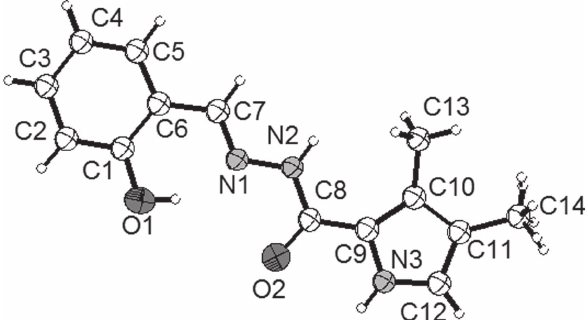
Table 1: Data collection and handling.